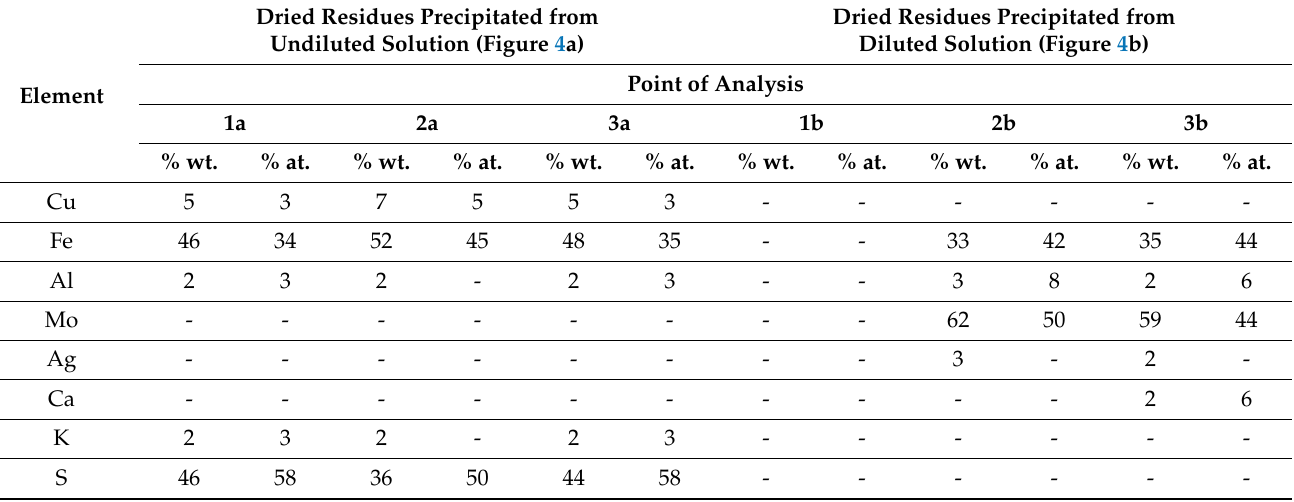
Table 2. Results of chemical composition analysis of the dried residues precipitated from control solution (EDS, SEM) at points shown in Figure 4; specimen from undiluted solution (Figure 4a), specimen from diluted solution (Figure